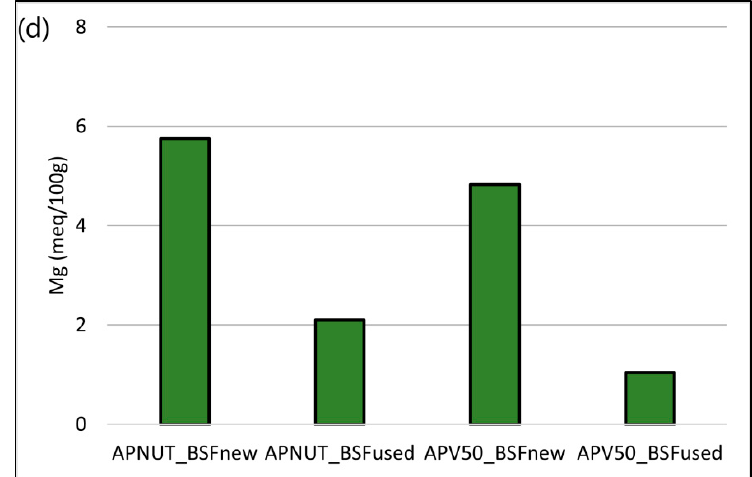
Figure 7. Concentrations of N ( a ), P ( b ), K ( c ), and Mg ( d ) in the coated PIMs before (APNUT_BSFnew, APV50_BSFnew) and after (APNUT_BSFused, APV50_BSFused) the use as fertilizers in the soil for 21 days. Instrumental uncertainty is equal to 20% of the values.